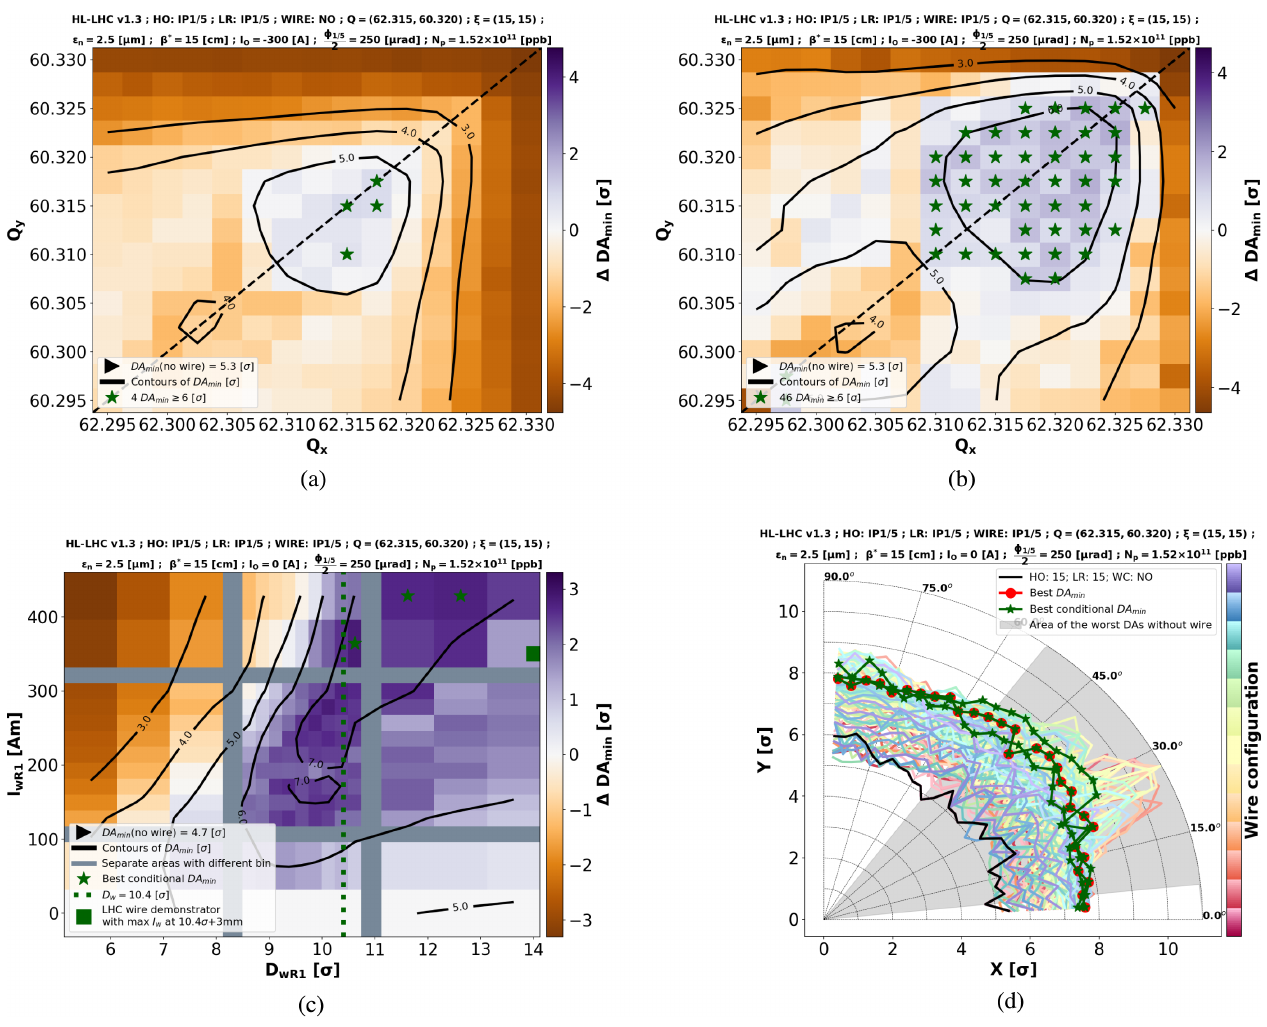
FIG. 5. HL-LHC ultimate scenario at the end of luminosity leveling. (a) and (b) Δ DA without and with wire compensator, respectively, (c) Δ DA configurations that guaranty DA